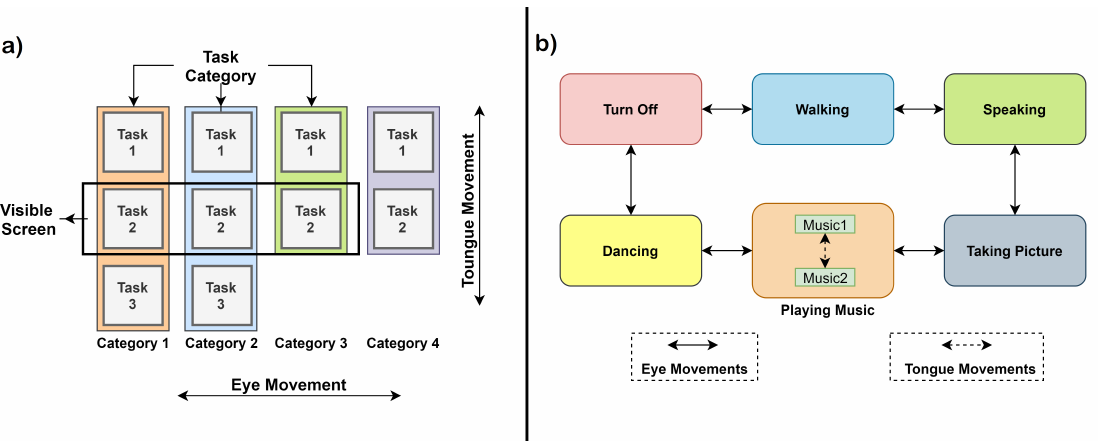
Figure 11. ( a ) Menu for selecting task, and ( b ) state diagram (adopted from: